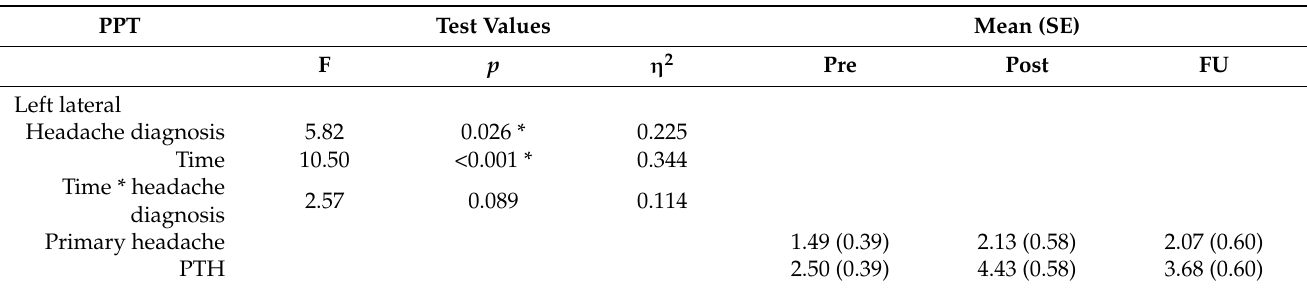
Table 3. Comparison of PPT changes across time between the primary headache group and PTH